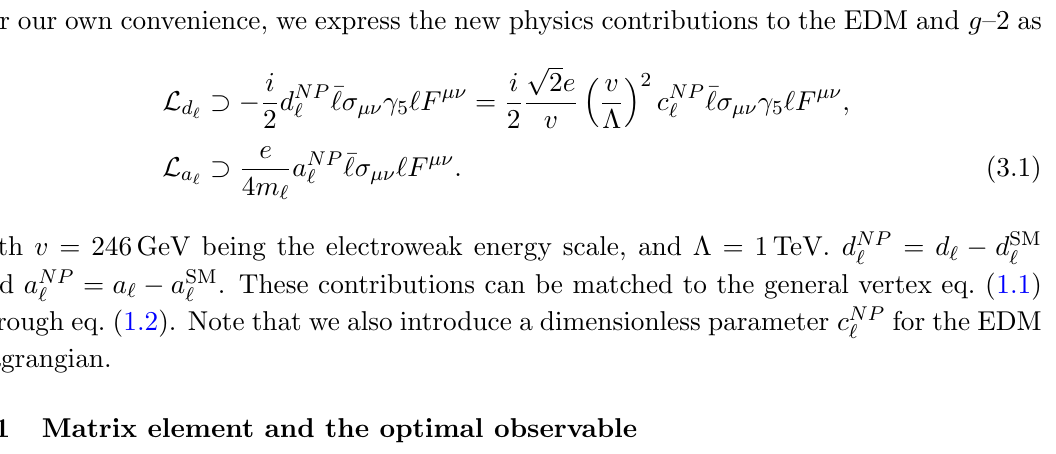
(cid:0) x truth I